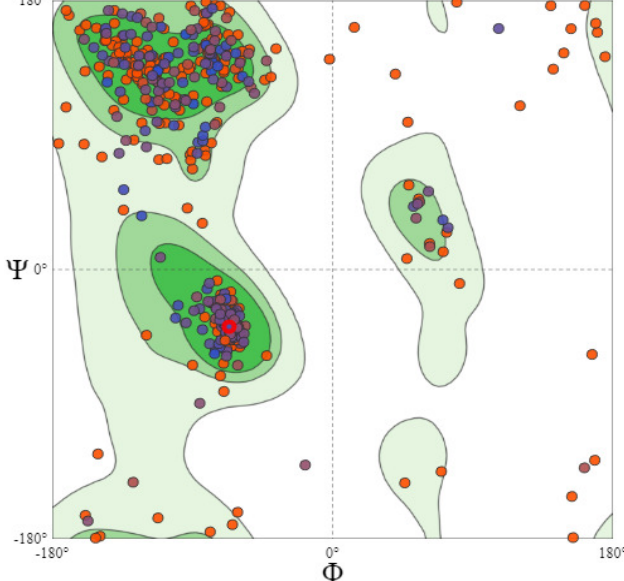
Figure 4. Ramachandran, the Bombyx-Aedes Model terrain. The most favorable regions are shown in dark green, neutral in light green, and non-favorable in white; each amino acid residue is marked with different colors, generated by the structure assessment program (https://swissmodel.expasy.org/assess/KGJVtX/01, accessed on 27 June 2021).